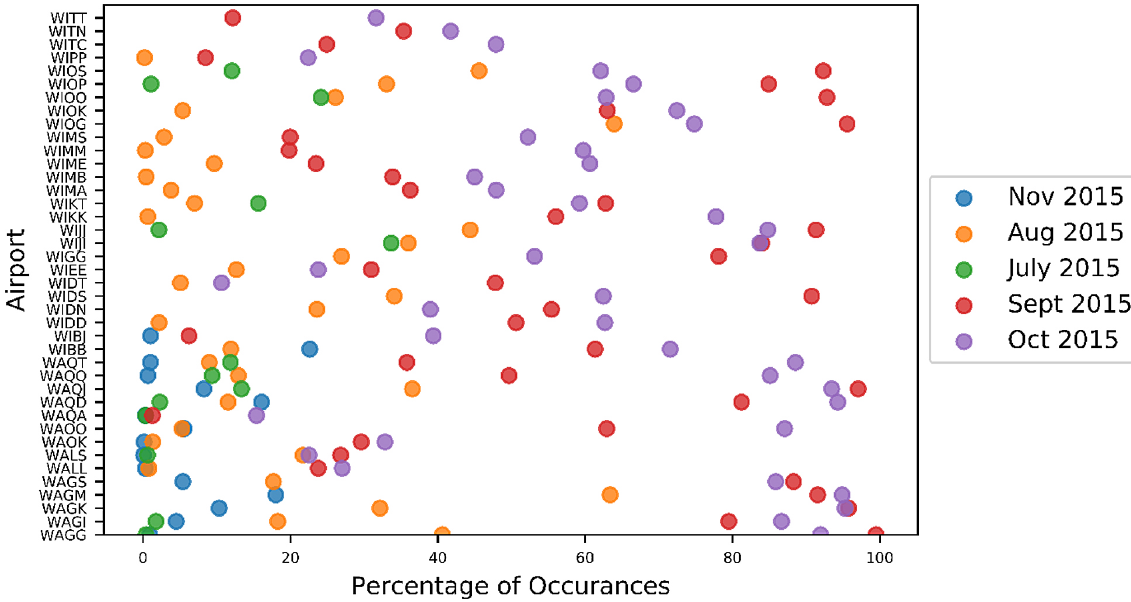
Fig. 2. Airport smoke frequency in month of July, August, September, October, and November 2015; no smoke occurred in December